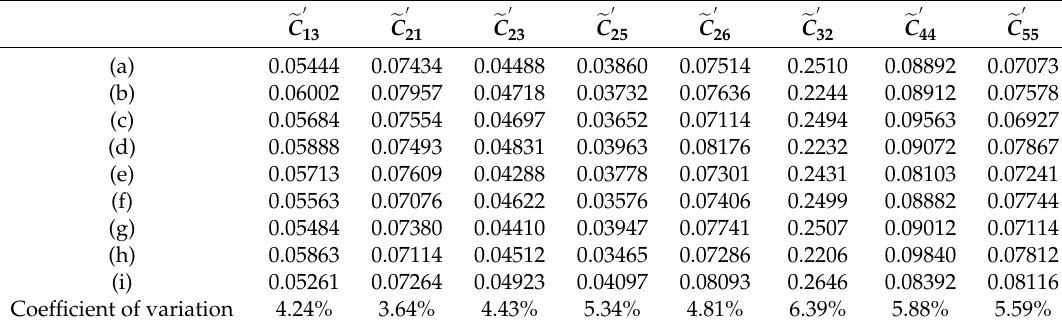
Figure 6. Pre-processed images of RTS transformation set. ( a ) Original image; ( b ) image rotated by − 20 ◦ and translated with [35, 25]; ( c ) image rotated by 15 ◦ and translated with [ − 35, − 25]; ( d ) image translated with [ − 35, − 25] and scaled with 0.8; ( e ) image translated with [35, 25] and scaled with 0.8; ( f ) image rotated by − 20 ◦ and scaled with 0.8; ( g ) image rotated by 20 ◦ and scaled with 1.2; ( h ) image rotated by − 15 ◦ and scaled with 1.2; ( i ) image rotated by 15 ◦ , translated with [35, 25] and scaled with 1.2. Table 5. Radial Chebyshev moment invariants of the images in Figure 6.